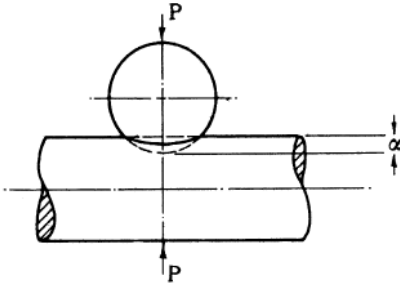
Figure 6. Perpendicular axes cylindrical contacts with equal diameters.